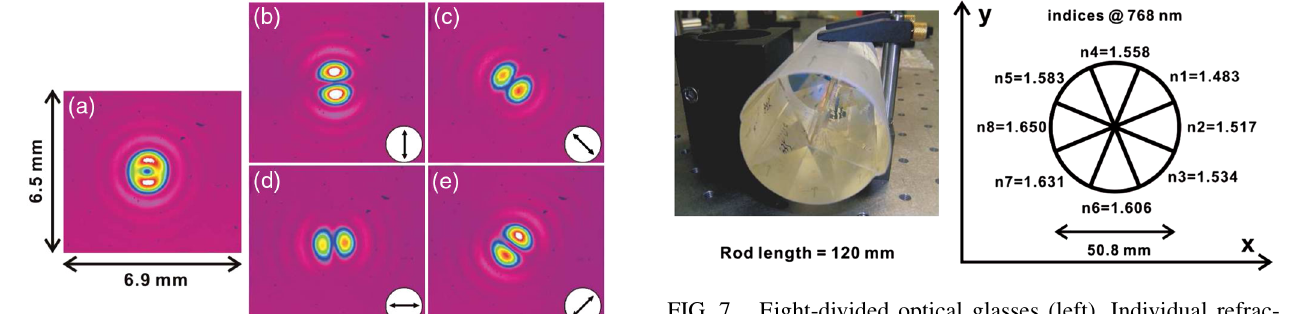
FIG. 7. Eight-divided optical glasses (left). Individual refrac- tive index (incident wavelength: 768 nm) is described in the schematic drawing (right).FIG. 5. Beam profiles after a spatial filter unit without (a) and